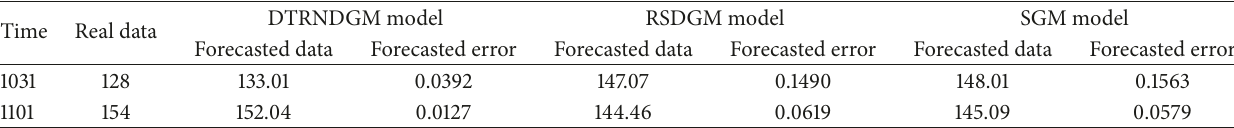
Table 4: Simulated or forecasted values and errors of traffic flow with the 𝜒 ∈ 𝑅 3×7×24×12 model.